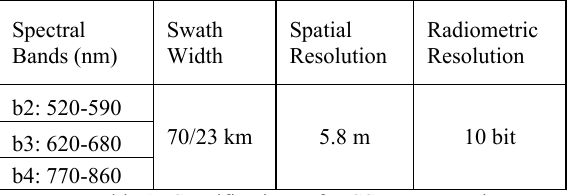
Table 1. Specifications of LISS-IV sensor data